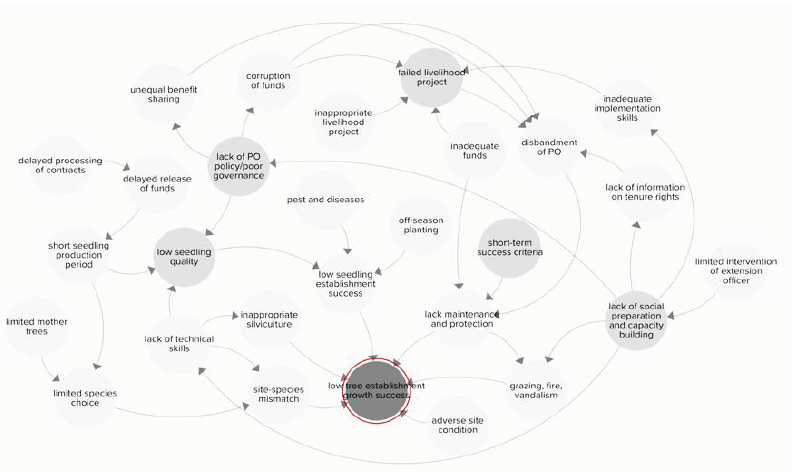
Figure 2. The influence diagram of issues contributing to the low survival of trees in past community- Figure 2. based forest restoration projects of Kawayanon Famer’s Association Incorporated (KFAI). community-based forest restoration projects of Kawayanon Famer’s Association Incorporated